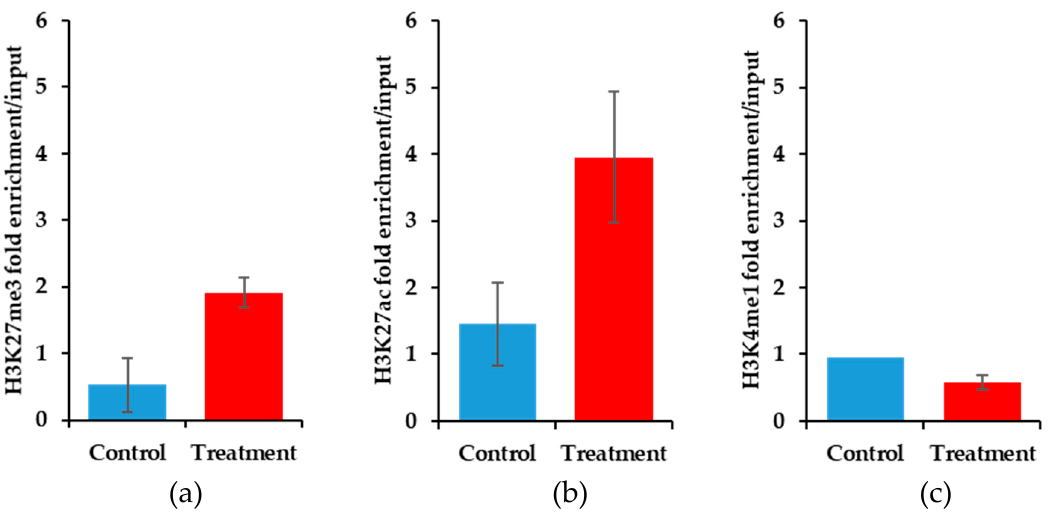
Figure 7. Epigenetic histone marks differ between control and YM155 treated mouse synovial sarcoma at the Birc5 promoter. ( a ) ChIP-qPCR for H3K27me3 shows elevated levels at the Birc5 promoter in the YM155 treated samples ( n = 5) compared to controls ( n = 3), error bars are SEM ( p = 0.045). ( b ) ChIP-qPCR for H3K27ac shows elevated levels at the Birc5 promoter in the YM155 treated samples ( n = 5) compared to controls ( n = 3), error bars are SEM ( p = 0.14). ( c ) ChIP-qPCR for H3K4me1 shows equally low levels at the Birc5 promoter between the YM155 treated samples ( n = 5) compared to controls ( n = 2), error bars for treated samples are SEM ( p = 0.13).